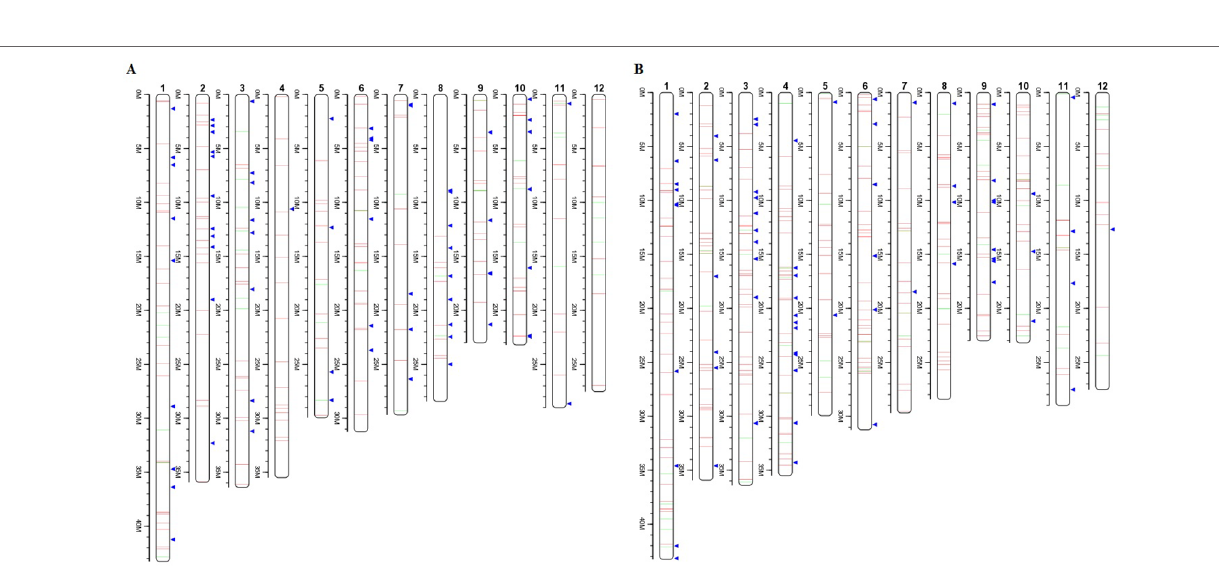
Frontiers in Plant Science |